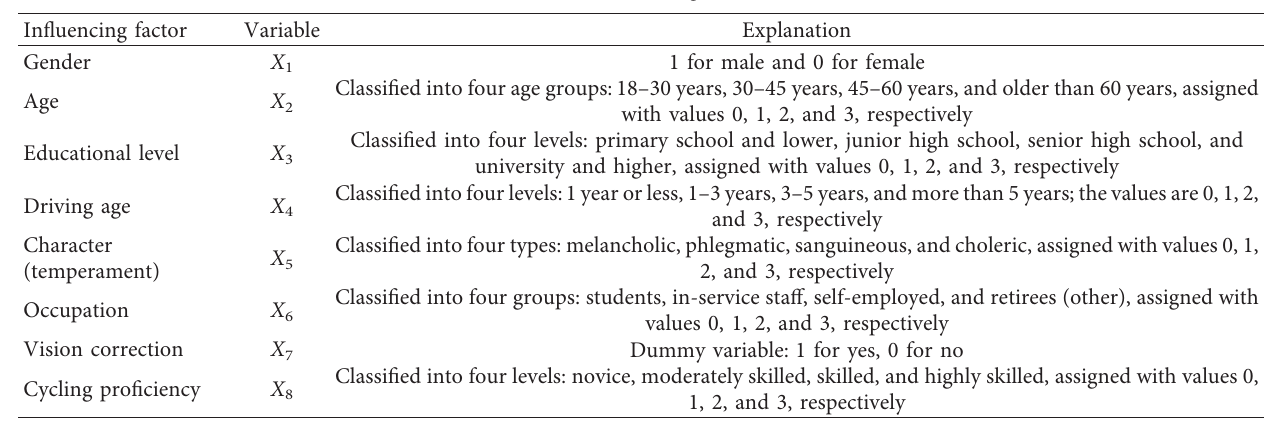
Table 2: Influencing factors.